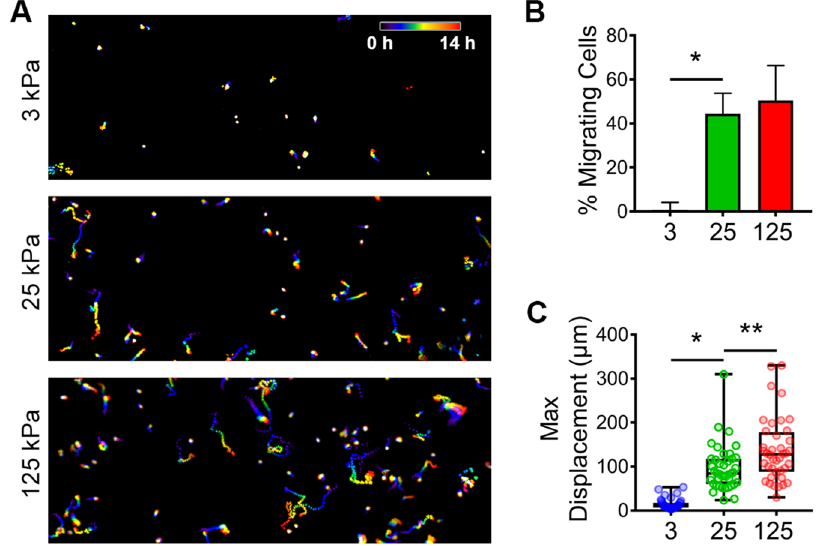
Figure 5. Substrate rigidity regulates ovarian cancer cell migration. ( A ) SKOV-3 cells plated on FN-coated 3, 25, and 125 kPa hydrogels were monitored by live-cell microscopy (capture rate = 4 frames/h) and nuclei were tracked using AIVIA software. Consecutive frames of time-lapse movies of were color-coded (as depicted by the “0 h–14 h” scale bar) and maximum intensity projections of the stacks were generated to show the cumulative cell tracks over 14 h. ( B ) Maximum displacements were calculated by determining the largest Euclidean distance between the position of each cell at t = 0 and its position at each frame of the time lapse image. The graph depicts all of the data points (colored symbols), with box & whisker plots showing maximum & minimum values (whiskers), the 25 th to 75 th percentiles (box), and the median value (box line). (n = 40 cells from 3 experiments; * p < 0.0001; ** p = 0.002 using a Mann-Whitney test). ( C ) The percent of migrating cells was calculated by determining the number of cells with a maximum displacement > 50 µ m versus the total number of cells per movie. (n = 79, 159, and 180 cells from 3 experiments for 3, 25, and 125 kPa samples, respectively; * p =